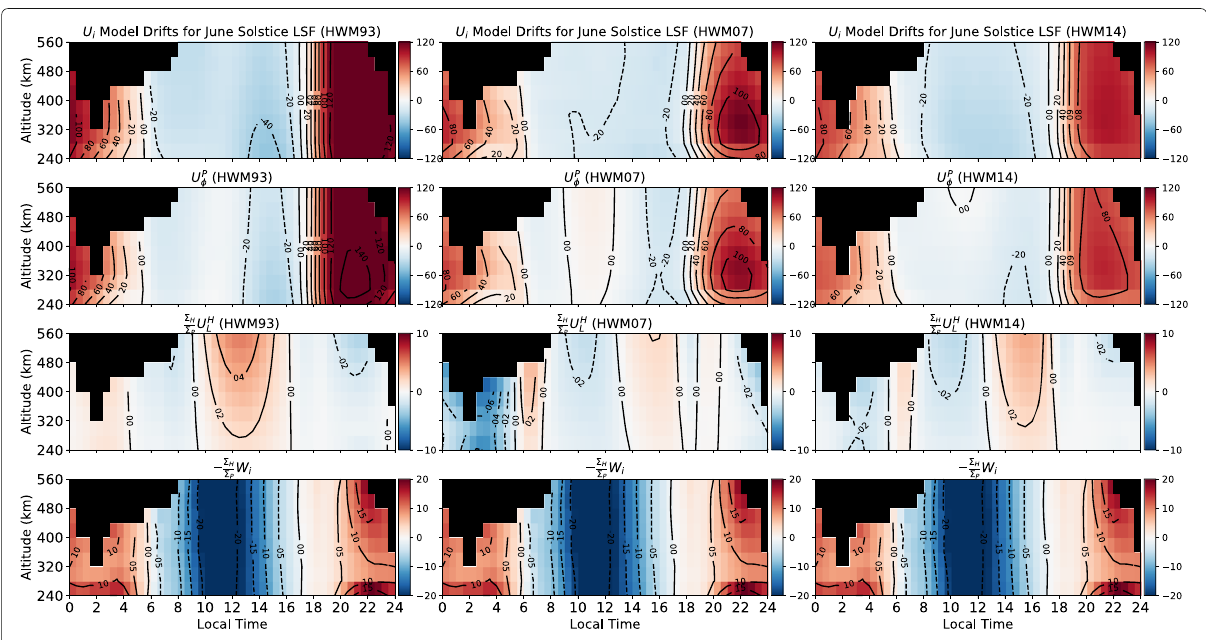
Fig. 7 The contribution of each term of Eq. 6 to the modeled zonal drifts. June solstice low solar flux (LSF) conditions